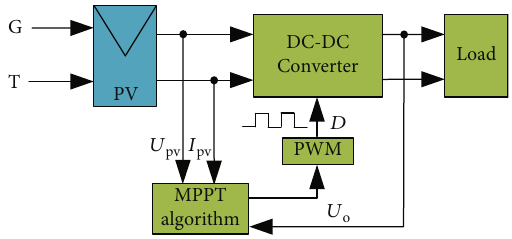
Figure 1: Framework of PV system with MPPT.